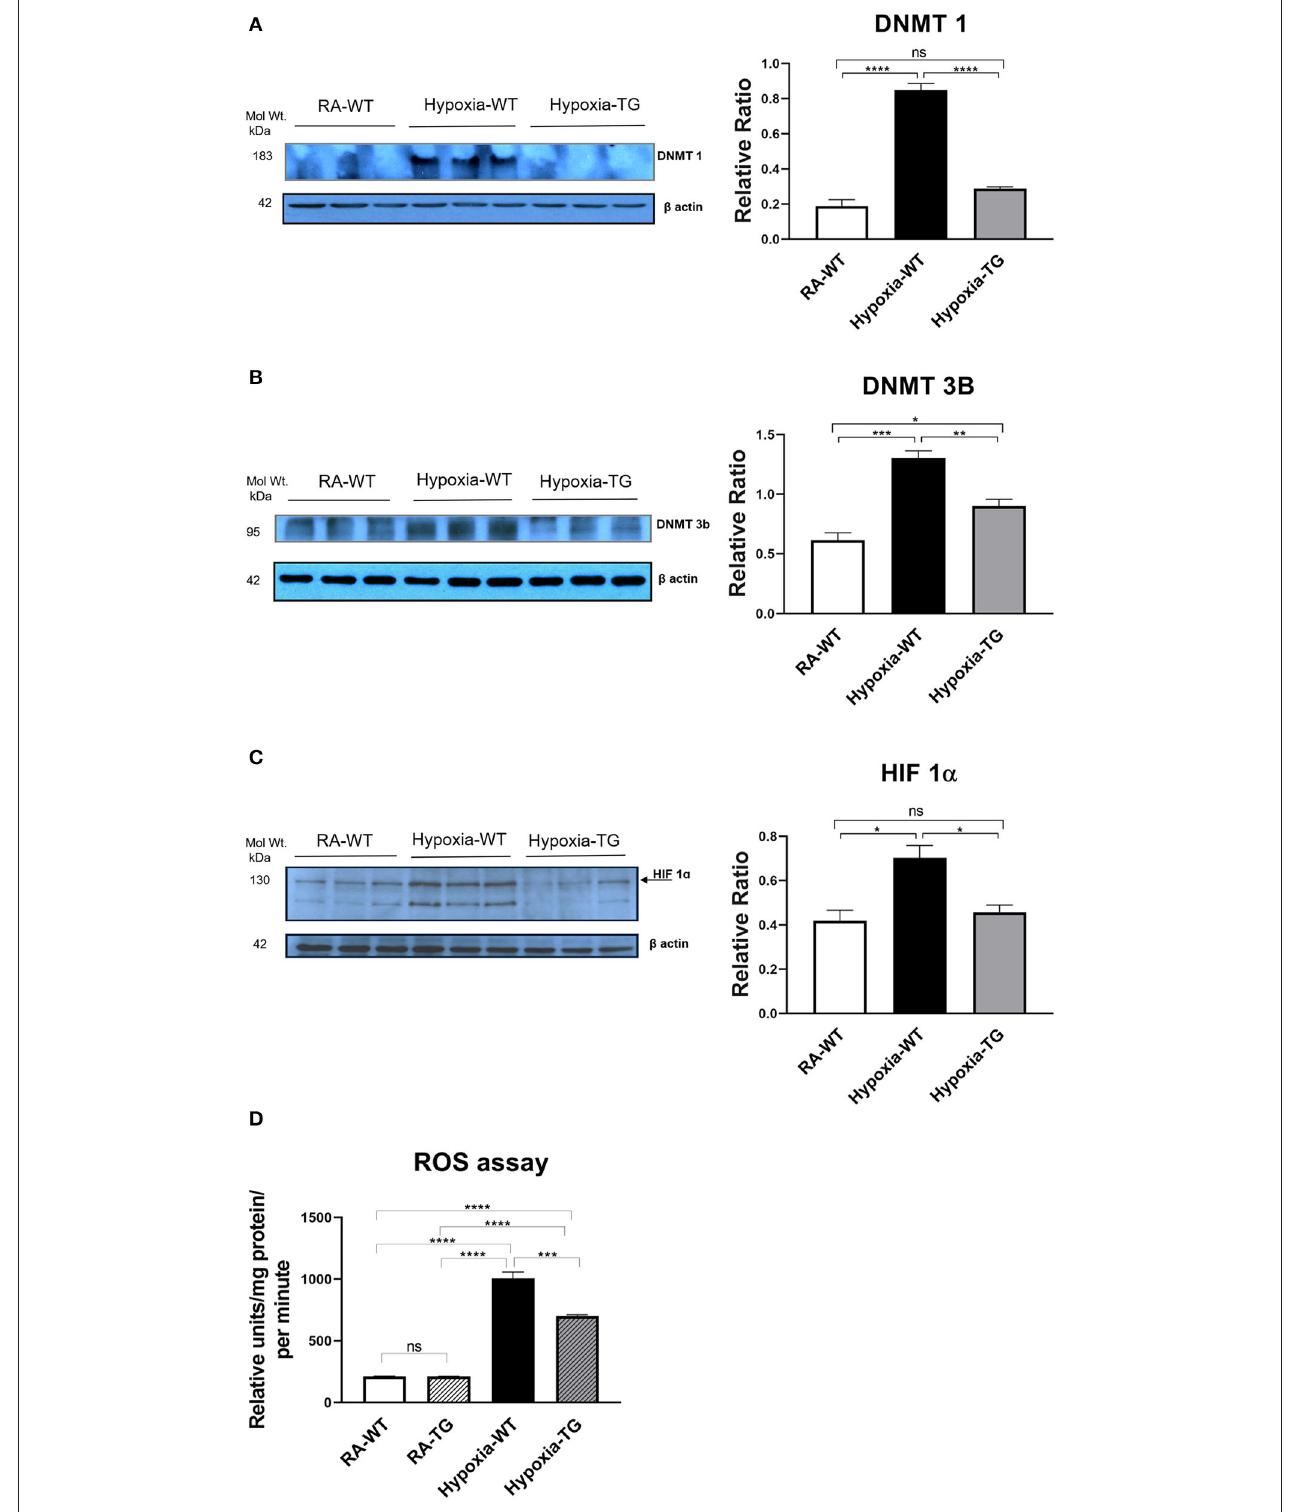
FIGURE 5 | Western blot analysis for DNMT1, 3b, and HIF-1 α . Adult mice (WT) and EC-SOD transgenic mice (TG) were exposed to FiO 2 10% hypoxia for 21 days. Room air animals were used as a control group (RA). WB analysis was used to assess protein levels of DNMT 1 (A) and DNMT 3b (B) ; HIF-1 α assessment in cardiac fibroblasts (C) in the right ventricular tissue. ROS assay in all studied groups (D) . All experiments were carried out in triplicate. Data represent mean ± SEM. * P < 0.05, ** P < 0.01, *** P < 0.001, **** P < 0.0001.